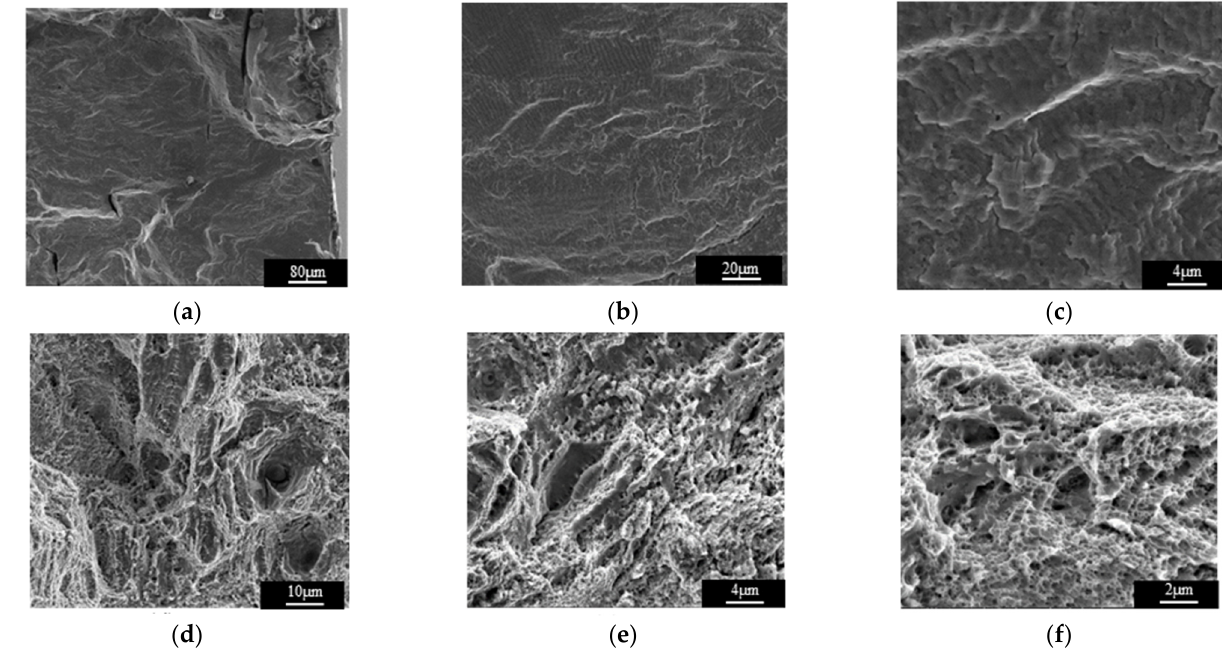
Figure 10. The SEM photographs of the fatigue fracture. ( a ) Fatigue source. ( b ) Low magnification of the fatigue expansion zone. ( c ) High magnification of the fatigue expansion zone. ( d ) Instantaneous fracture zone. ( e ) High magnification of the instantaneous fracture zone. ( f ) High magnification of the instantaneous fracture zone.